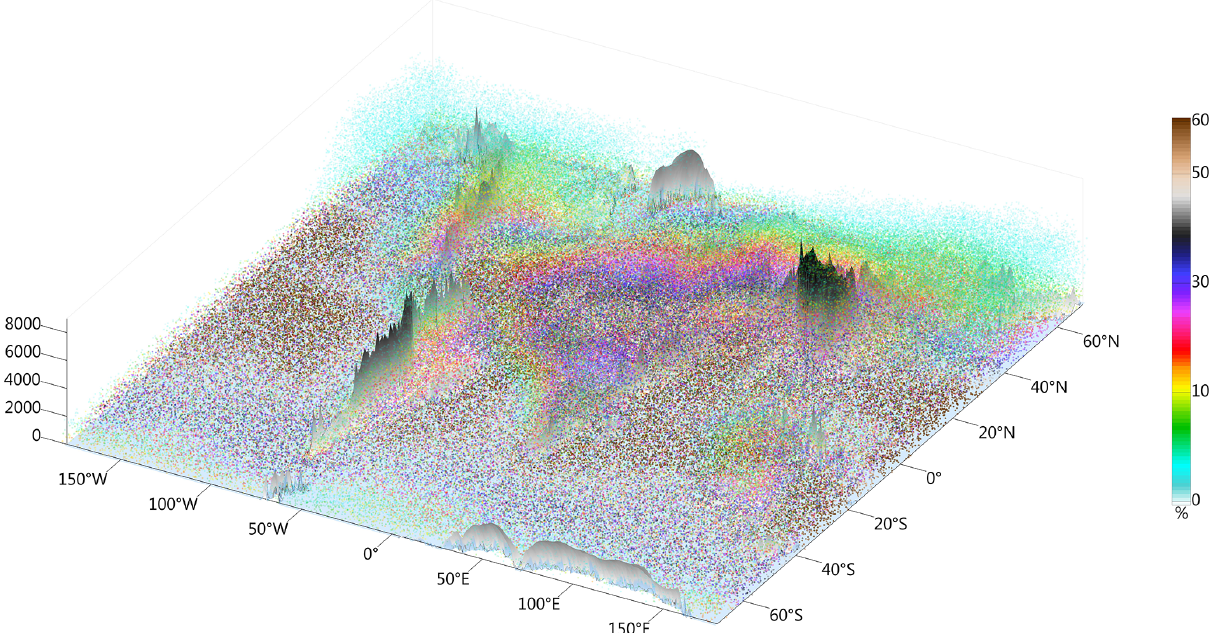
Figure 10. 3D particle map of the annual FoO for all aerosol types averaged over 13 years (2007–2019).